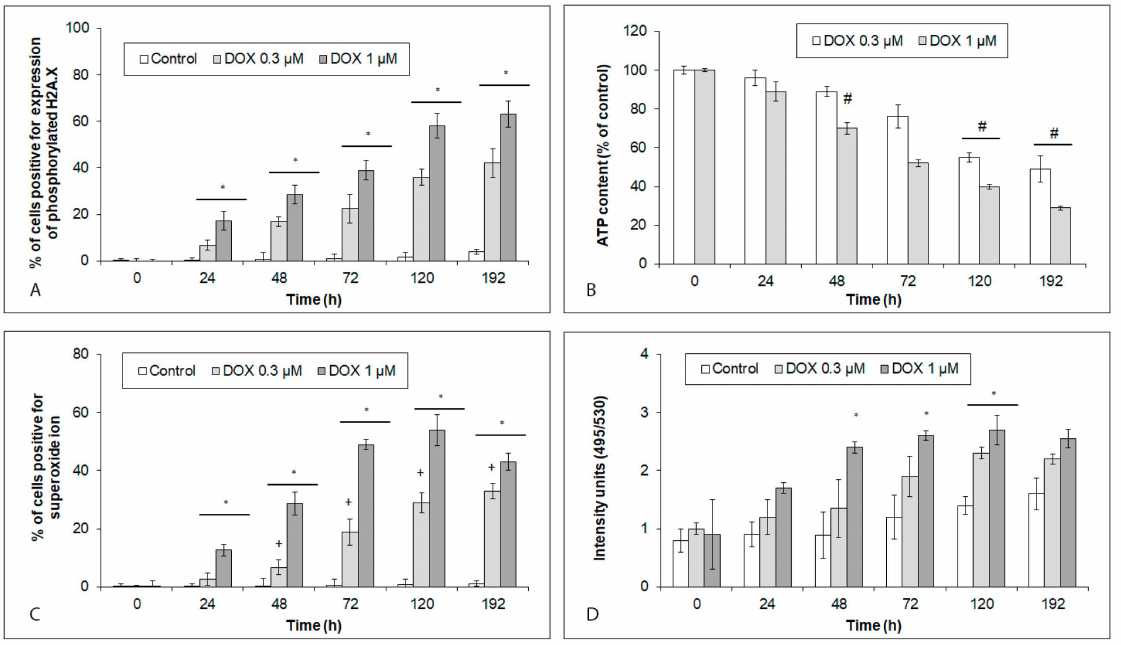
Figure 2. Effects of 0.3 µ M and 1 µ M DOX on various intracellular targets in hiPCS-CMs during 192 h. Control and DOX-exposed cardiomyocytes were harvested at individual time intervals, and ( A ) DNA damage, ( B ) mitochondrial production of ATP, ( C ) generation of superoxide ion, and ( D ) lysosomal membrane permeabilization, were determined by particular assays and procedures, as described in Section 4. Values represent means ± SD of N = 3 (DNA damage), N = 3 (ATP production), N = 3 (superoxide), and N = 3 (lysosomal permabilization) experiments. * p < 0.05 compared to untreated control cells at the same treatment interval; # p < 0.05 compared to untreated control cells at the same treatment interval; and + p < 0.05 compared to 1 µ M DOX treated cells at the same treatment interval with one-way ANOVA test and Dunnett’s post test for multiple